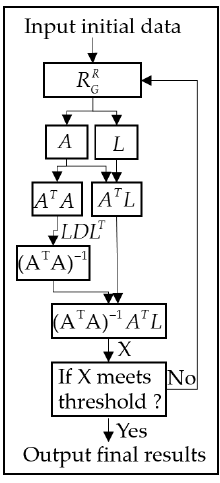
Figure 4. Flowchart of the whole algorithm.